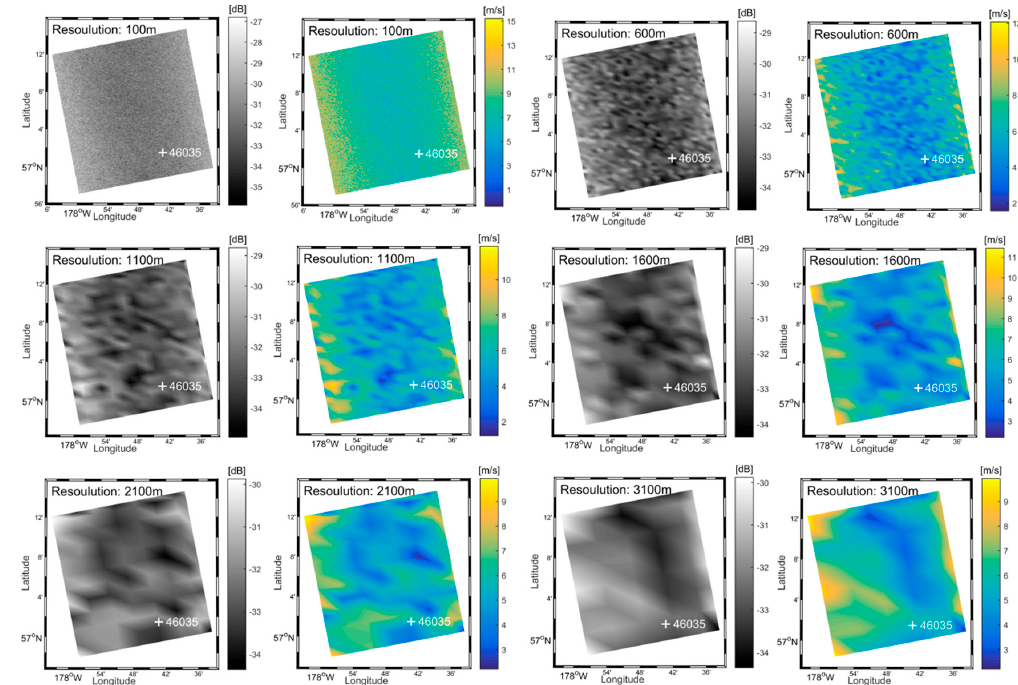
Figure 14. VH-polarized SAR images at reconstructed spatial resolutions of 100, 600, 1100, 1600, 2100 and 3100 m and corresponding OSWSs retrieved from C2PO model. The in-situ buoy (#46035, 57°1 ′ 33 ″ N 177°44 ′ 16 ″ W) wind speed is 2.92 m/s. RADARSAT-2 Data and Product MacDonald, Detteiler and Associates Ltd., All Rights Reserved.